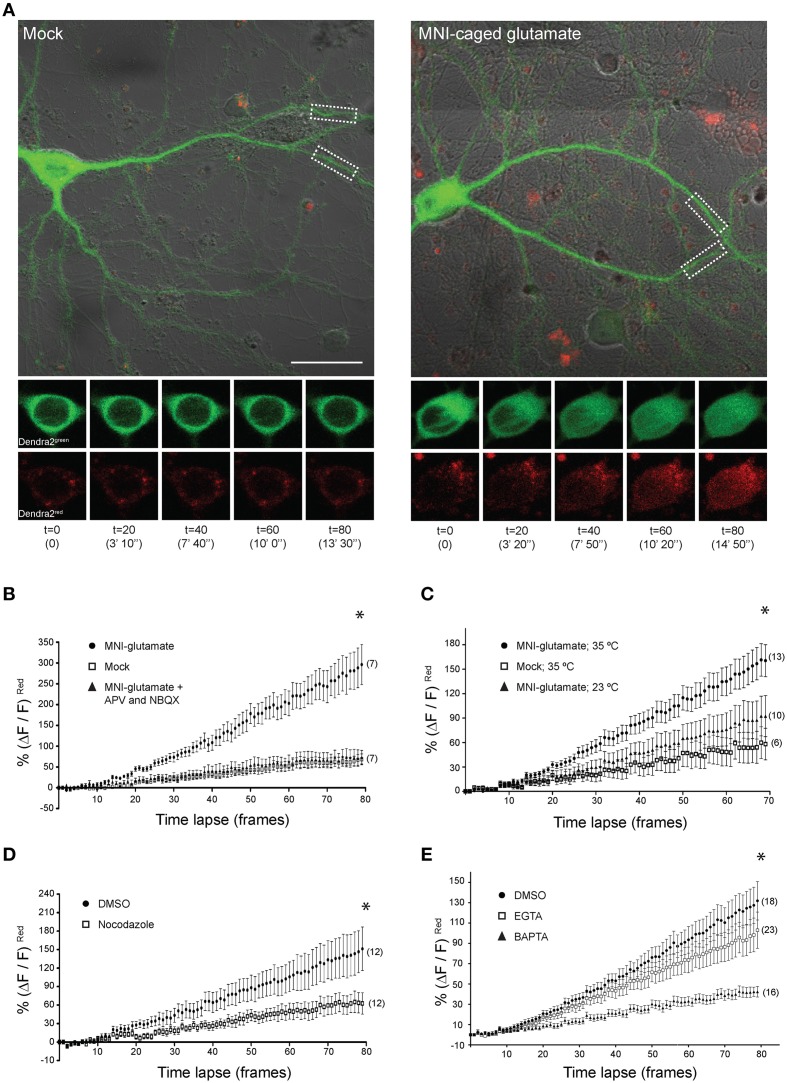
Local uncaging of glutamate at synapses can drive distally-localized CRTC1270 into the nucleus. (A) Neurons expressing CRTC1270 were illuminated with a UV laser in the presence or absence (mock) of MNI-caged glutamate. The white dashed boxes indicate the region of activation (~10 um; ROA). Time-lapse images of the soma at every 20th frame (time stamp in parenthesis) are shown for CRTC1270 in both native green and photoconverted red channels. Scale bar = 20 μm. (B–E) Neurons expressing CRTC1270 were stimulated with (B) mock or MNI-glutamate in the presence or absence of APV and NBQX (*p = 0.49 mock vs. APV/NBQX; p < 0.0001 MNI vs. mock and APV/NBQX), (C) MNI-glutamate at 35°C or 23°C (*p < 0.0001 Mock 35°C vs. MNI 35°C, Mock 35°C vs. MNI 23°C, and MNI 35°C vs. MNI 23°C), (D) MNI-glutamate after incubation with NDZ (*p < 0.0001 DMSO vs. NDZ), or (E) pretreated with either BAPTA-AM or EGTA-AM prior to glutamate uncaging (*p < 0.0001 DMSO vs. EGTA vs. BAPTA and EGTA vs. BAPTA). Statistics were performed with linear regression analysis of the slopes for comparison of fit between data sets.